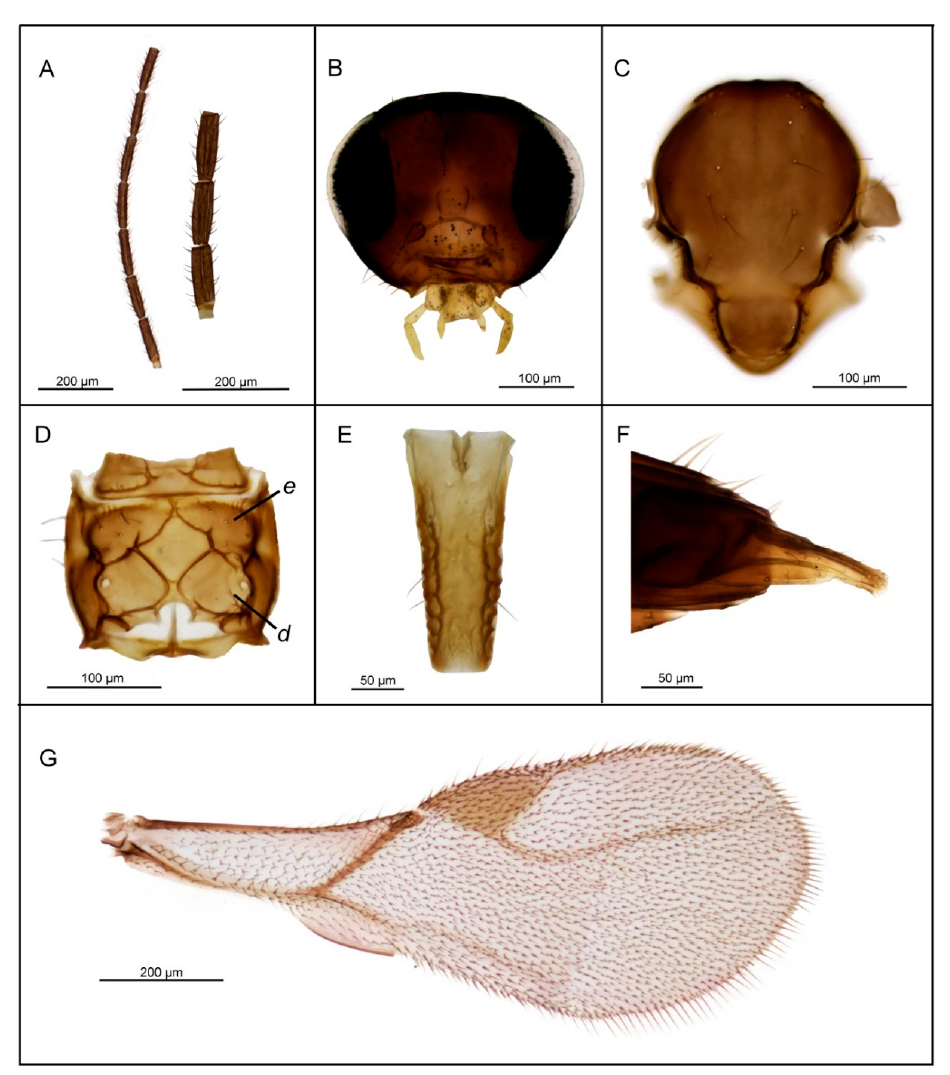
Figure 4. Lipolexis bengalensis sp. n., female: ( A ) antenna and F1–F3; ( B ) head; ( C ) mesoscutum; ( D ) propodeum; ( E ) petiole, dorsal view; ( F ) ovipositor sheath; ( G ) forewing; e external areola, d dentiparal areola.